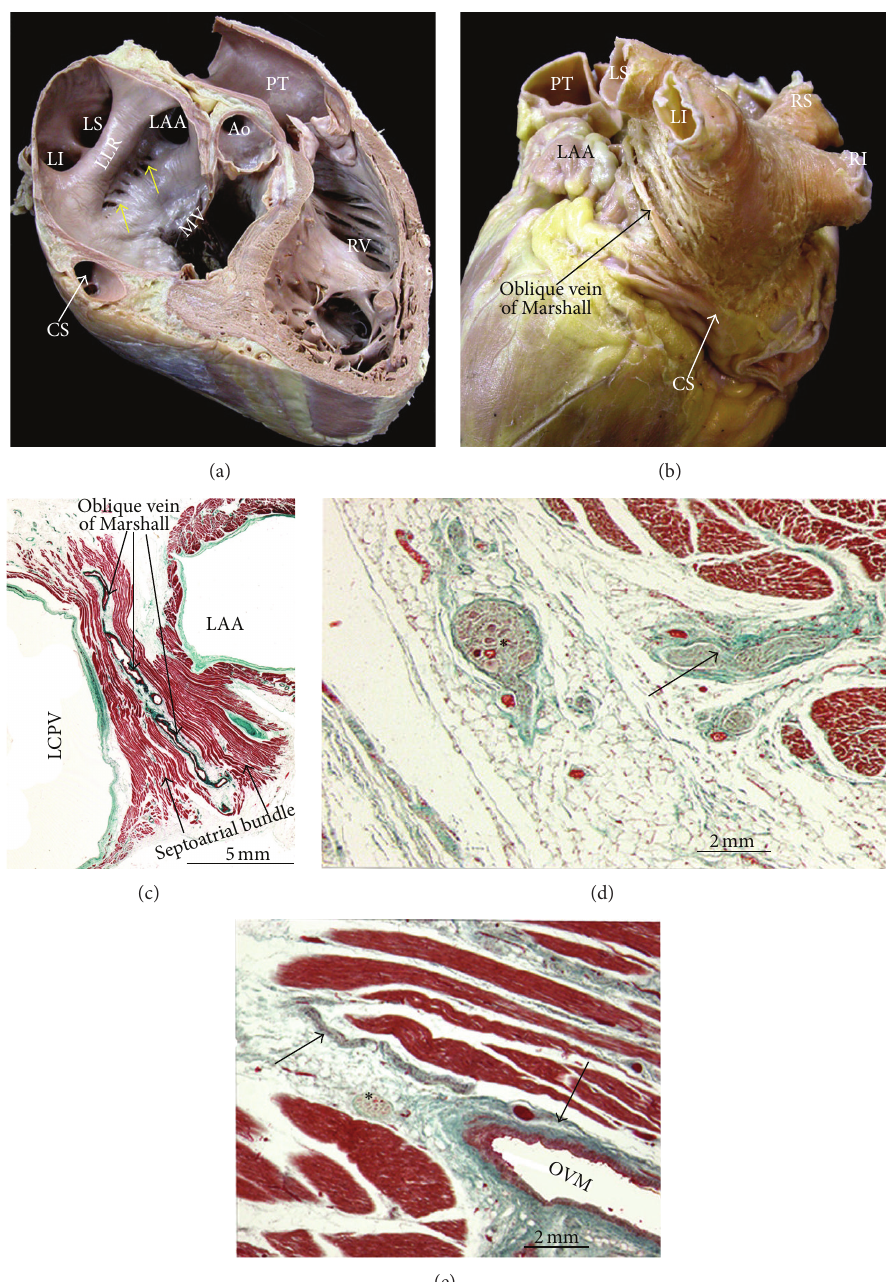
Figure 7: (a) Longitudinal section through the roof of the left atrium showing the endocardial view of the left atrium and right ventricle. Note the prominent left lateral ridge between the ostium of the left atrial appendage and the orifice of the left superior pulmonary vein. In this specimen, extra pectinate muscle trabeculations are extending inferiorly from the appendage to the vestibule of the mitral valve (arrows). (b) Posterolateral view of the left atrium and left ventricle to show the myofiber arrangement in the subepicardium of the left lateral ridge, left pulmonary veins, and the trajectory of the oblique vein of Marshall. Note that the vein of Marshall is in direct contact with the myocardium of the ridge. (c), (d), and (e) Cross-histological sections of the left lateral wall of the left atrium stained with Masson’s trichrome. (c) shows the oblique vein of Marshall in direct contact with the myocardium of the septoatrial bundle. (d) and (e) show the epicardial ganglion ( ∗ ) and autonomic nerve bundles (arrows) in the vicinity of the oblique vein of Marshall. LAA = left atrial appendage, PT = pulmonary trunk, Ao = aorta, MV = mitral valve, RV = right ventricle, CS = coronary sinus, LI = left inferior pulmonary vein, LS = left superior pulmonary vein, LLR = left lateral ridge, RI = right inferior pulmonary vein, RS = right superior pulmonary vein, OVM = oblique vein of Marshall, and LCPV = left common pulmonary